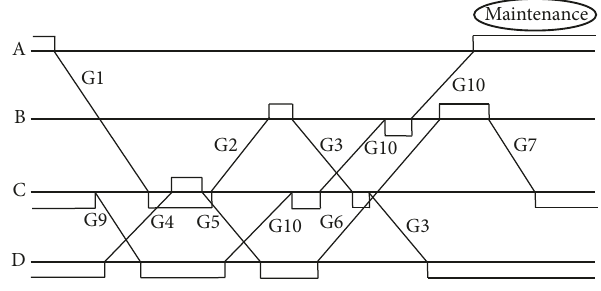
Figure 3: Train-set circulation plan.